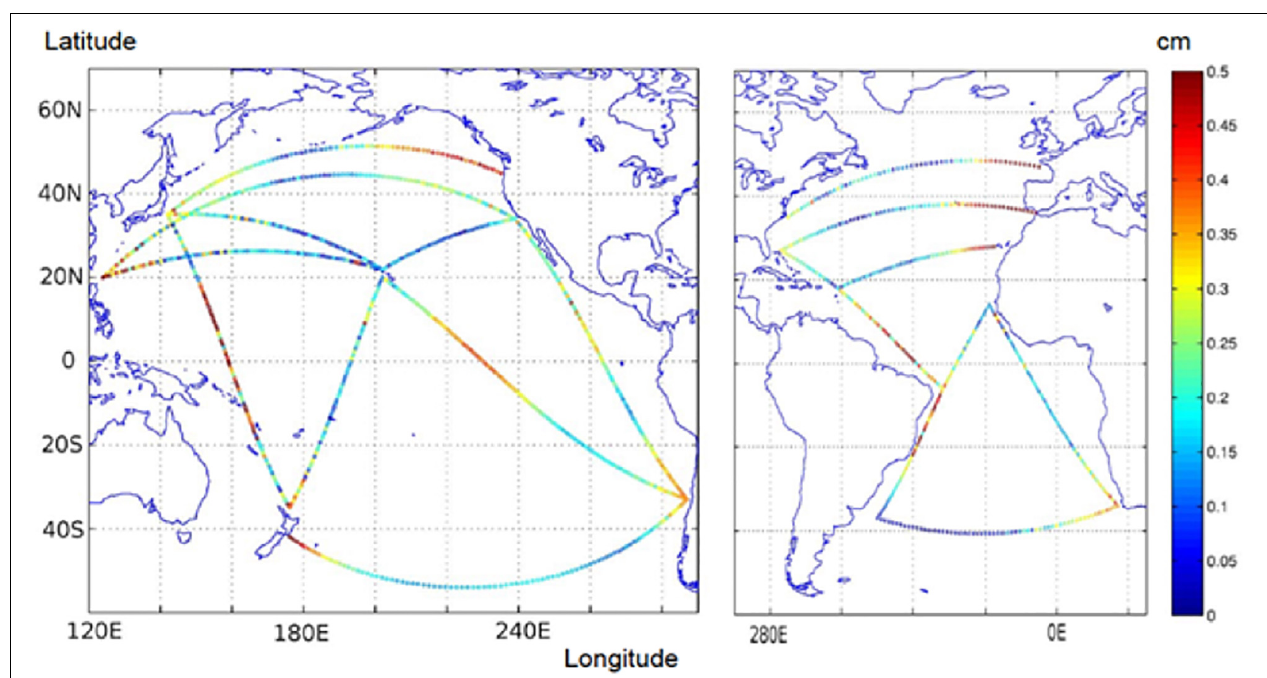
FIGURE 6 | Seasonal amplitude (cm) of the principal lunar semi-diurnal tide M2 along cable routes simulated with the STORMTIDE model forced by both atmospheric fields and the astronomical tidal potential (Müller et al., 2014). Permission obtained for use of figure.